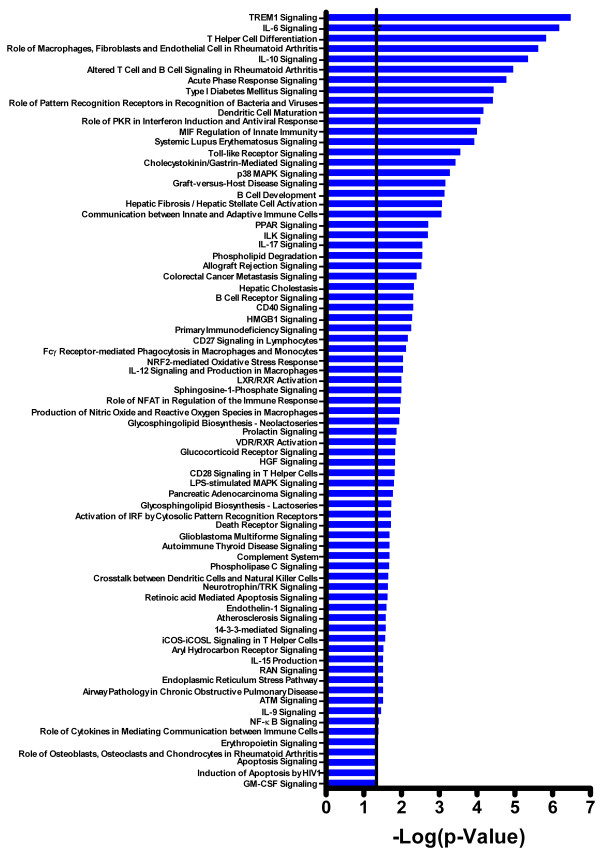
Canonical pathways significantly altered across all examined brain regions of sarin-exposed seizing animals. The dataset was filtered on brain region (amygdala, hippocampus, piriform cortex, septum, or thalamus), and a two-way interaction ANOVA was used to identify genes most significantly altered in each brain region based on exposure (saline or sarin) and time after seizure onset. The significant genes from each ANOVA (p-value ≤ 0.05) were compared using a Venn diagram, and the top 800 overlapping genes that mapped to canonical pathways in the IPA Knowledge Base were analyzed. The pathways that were significantly affected across all five brain regions are shown (p < 0.05, Fisher's exact test), with a threshold of 0.05 (or 1.3 when expressed as -log(p-value)) marked by an asterisk.